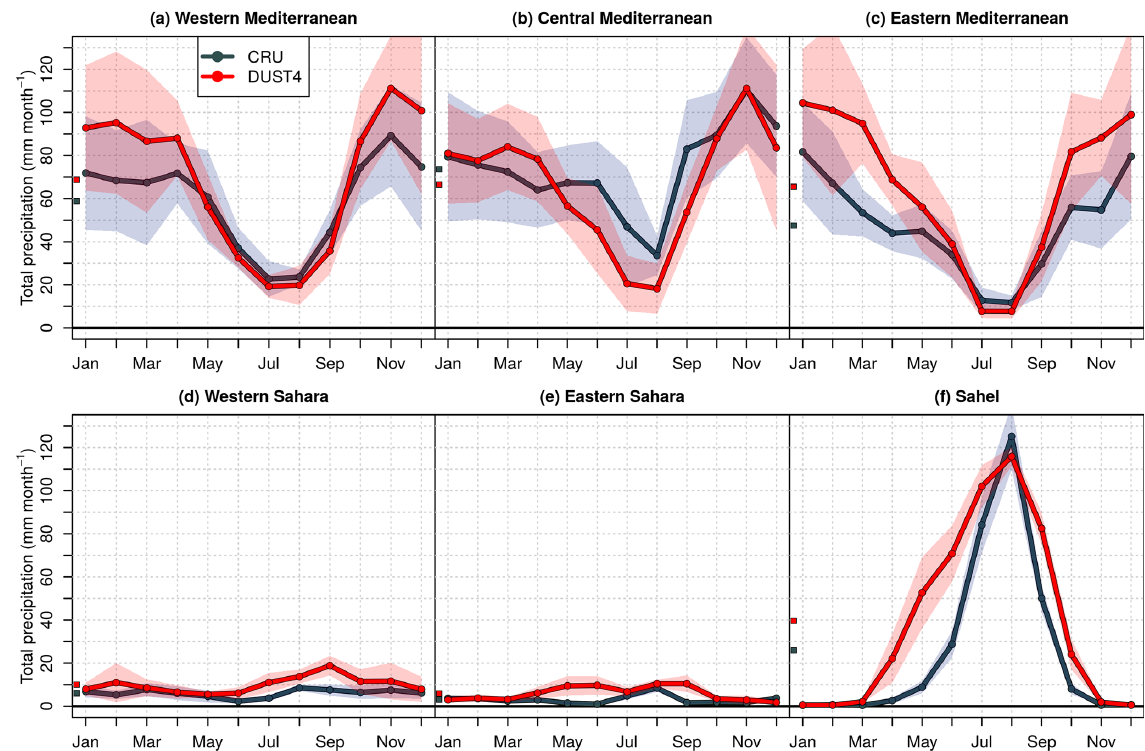
Figure 9. Total precipitation annual cycle of the ERA-Interim and DUST4 experiment for the period December 2006 to November